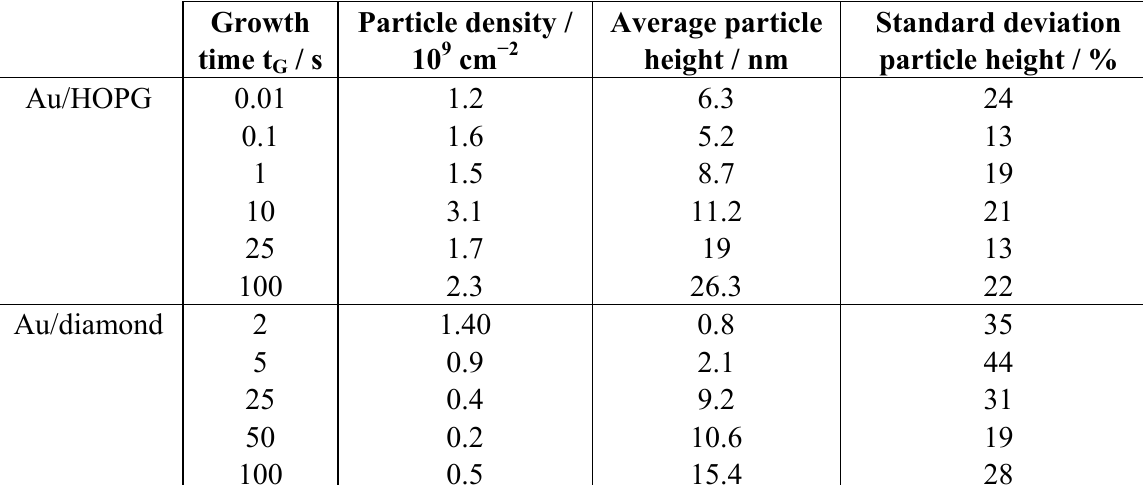
Table 1. Evaluation of TM-AFM measurements of Au/HOPG and